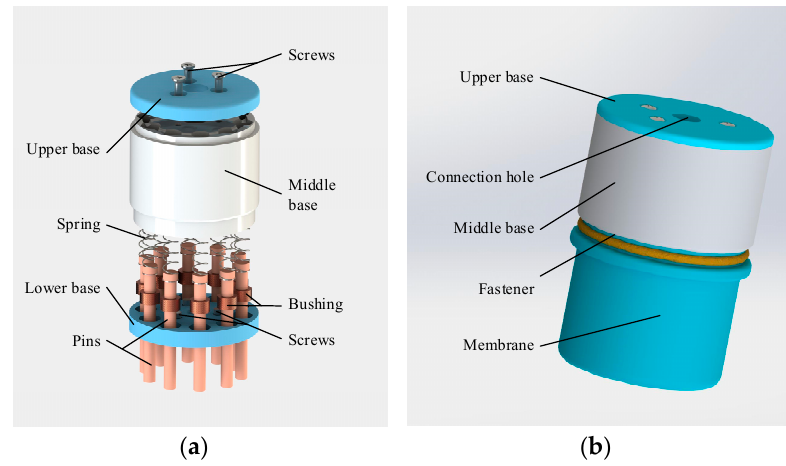
Figure 6. The design of the CTSA-II hand: ( a ) the explosion view, ( b ) the overall appearance.